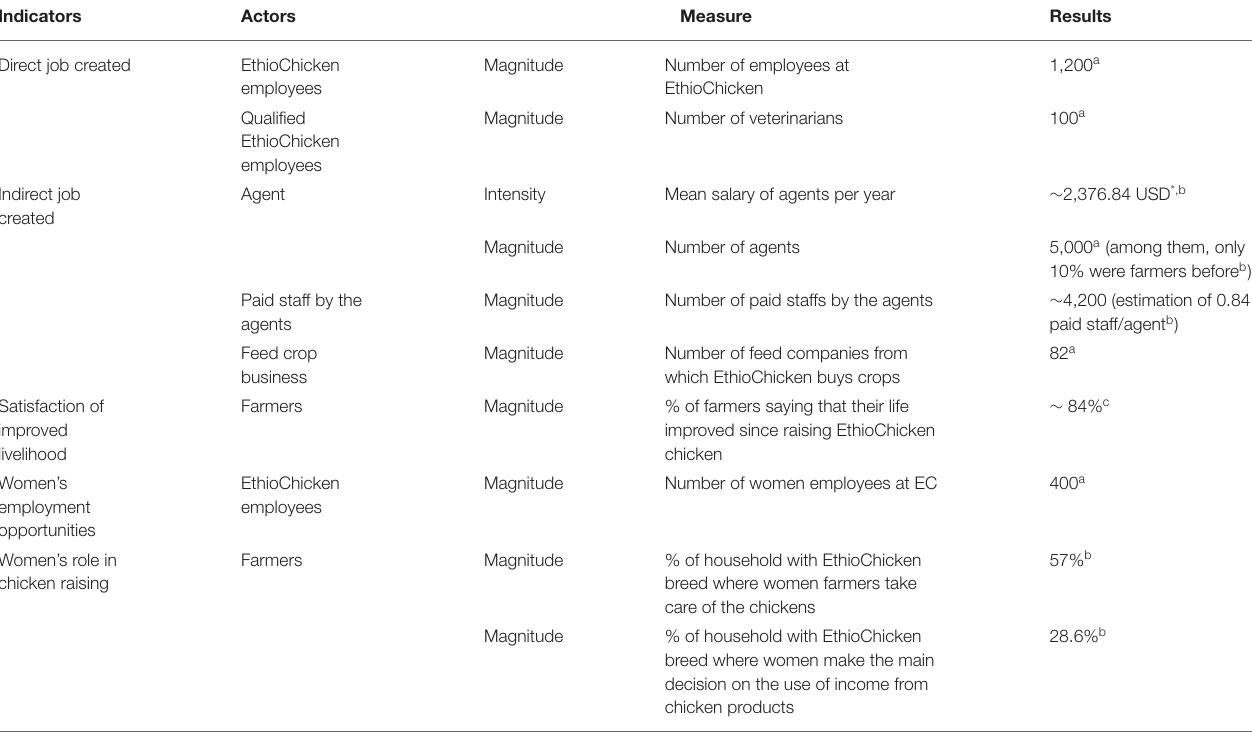
TABLE 2 | Indicators of societal impacts related to different stakeholders generated by the PPPs between the Ethiopian government and